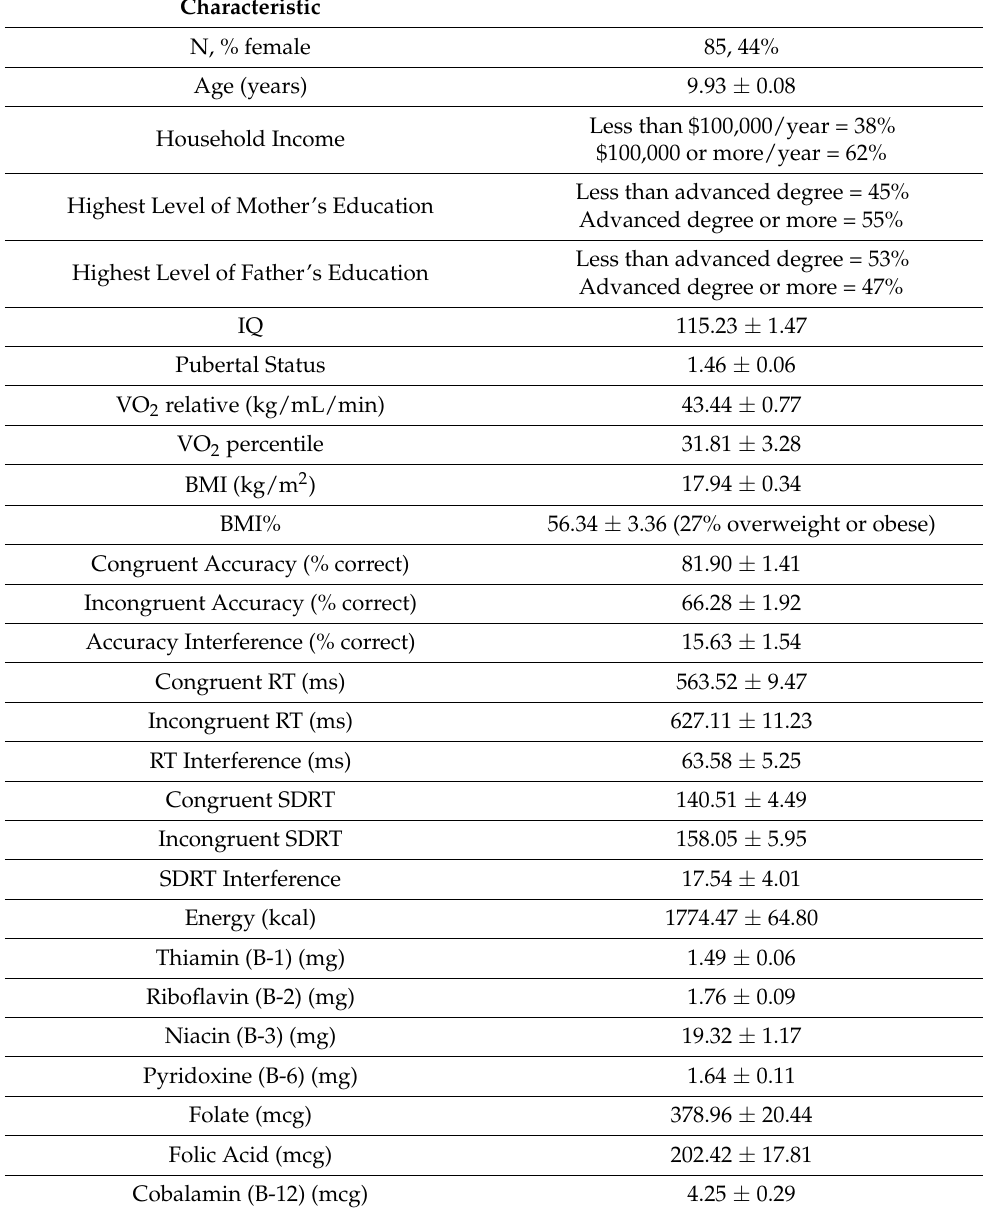
Table 1. Participant demographic information (Mean ±